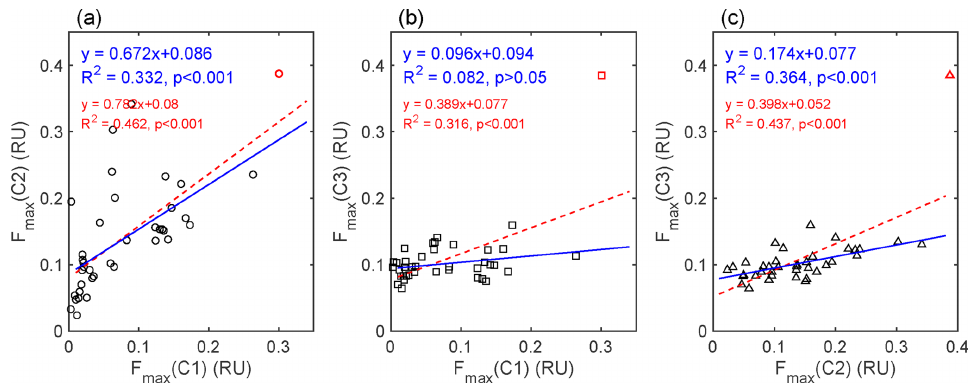
Figure 8. Linear relationships between intensities of (a) C1 and C2, (b) C1 and C3, and (c) C2 and C3. The red dashed lines show the fits of the entire data set, and the blue solid lines show the fits of the data excluding site 67 (shown as markers in red). The corresponding fitting parameters are exhibited in the same color.